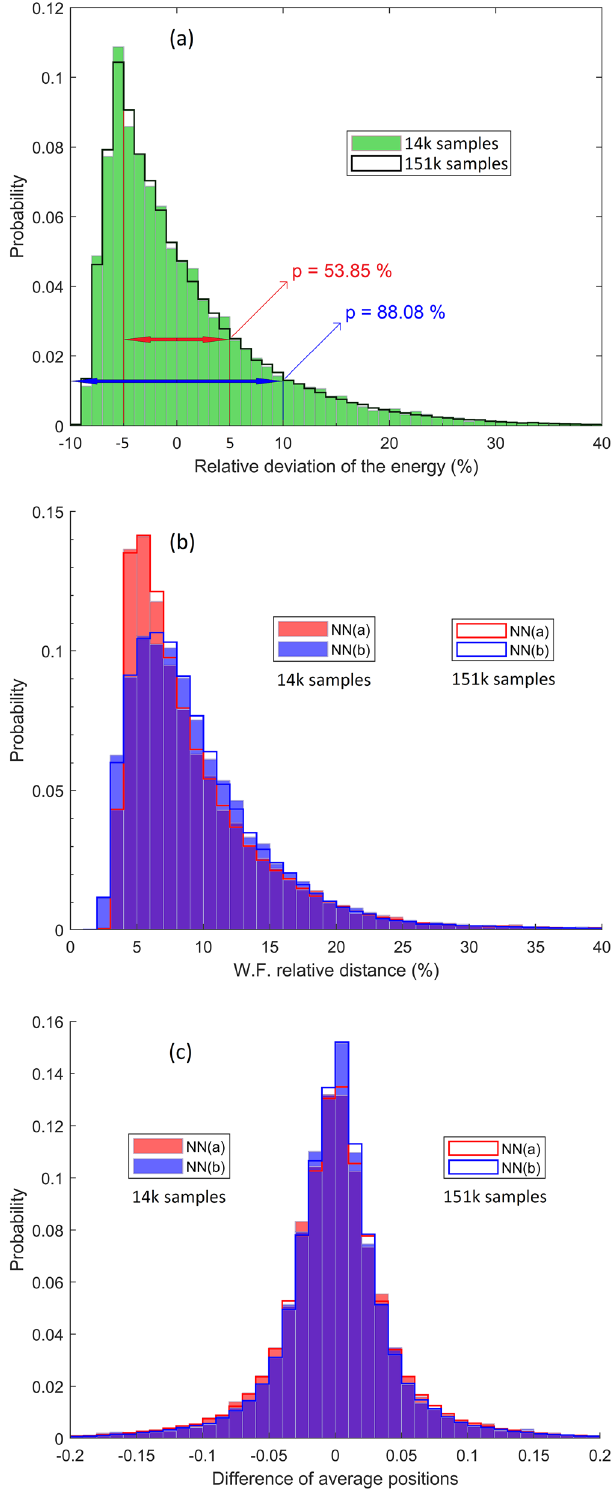
Figure 4. Multiple histograms comparing the NNs estimations for 14 k and 151 k samples in the training DS1: ( a ) relative deviation of energies; ( b ) relative “distance” between wave solutions; ( c ) accuracy of average positions. The height of a histogram bar indicates the probability to get a result in the corresponding bin. The bins cover uniformly the range of possible values on the horizontal axis. The face-colored bars are for the 14 k samples set and the edge-colored bars are for the entire 151 k samples